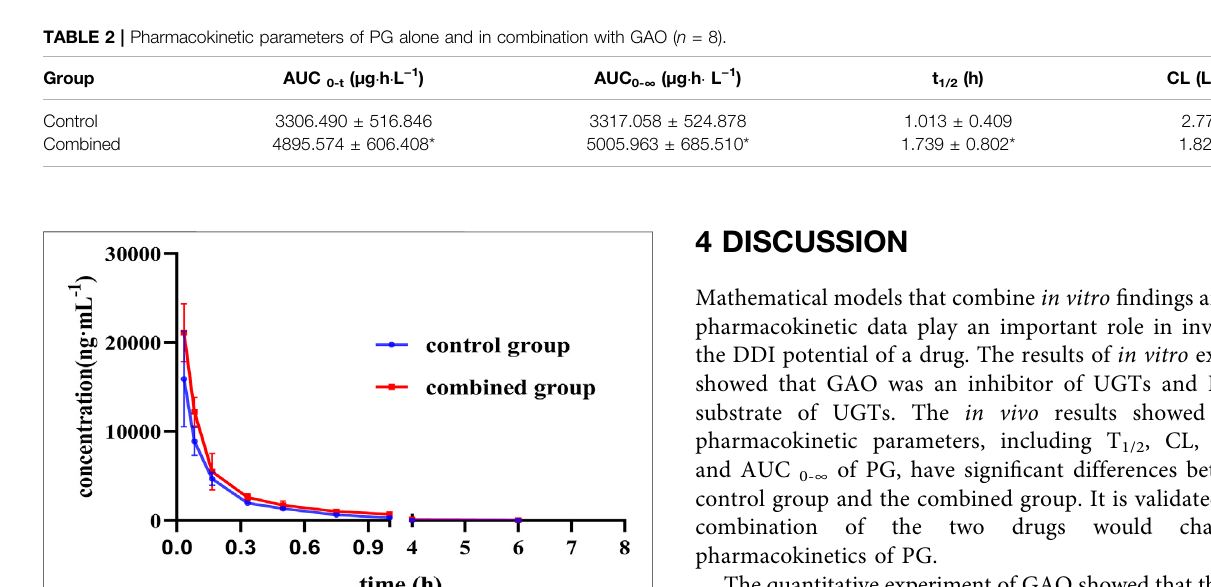
Figure 6 . Pharmacokinetic parameters were calculated under a noncompartmental model using Drug and Statistics 1.0 (DAS